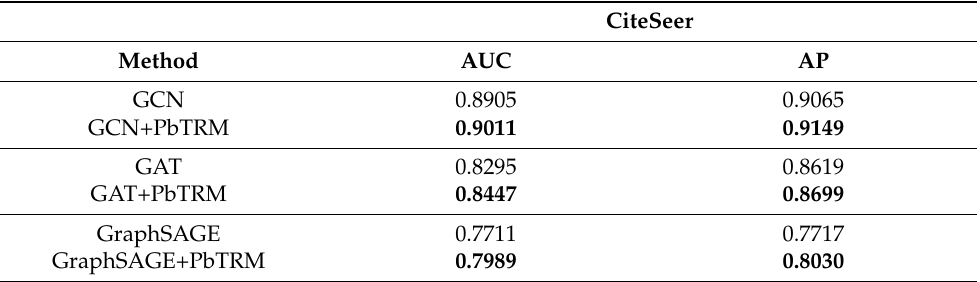
Table 3. The comparison of prediction performance between GNN+PbTRM and benchmarking GNN models on